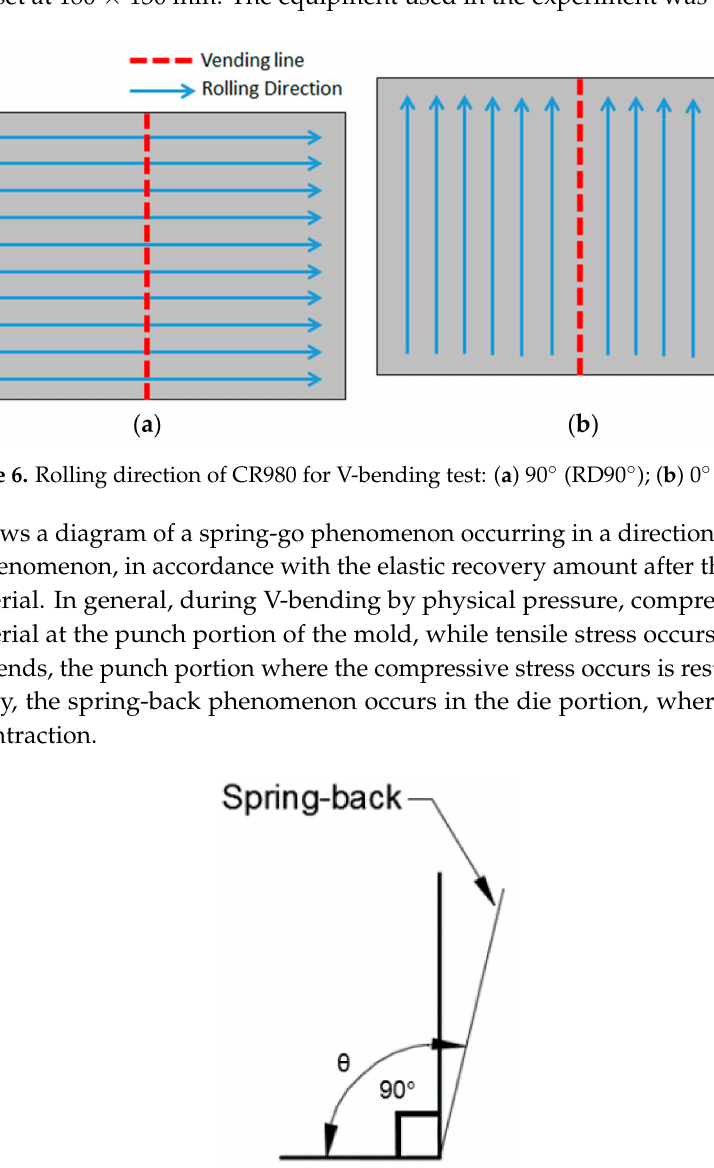
Figure 7. A conceptual view of the